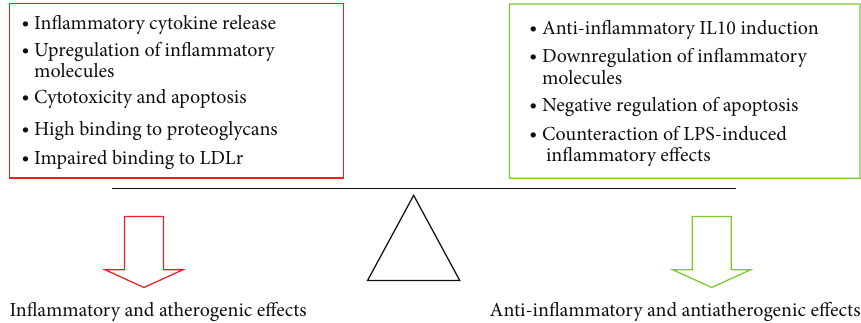
Figure 3: Balance of inflammatory and anti-inflammatory effects of LDL( − ) on cells. LDLr: LDL receptor, IL10: interleukin 10, LPS: